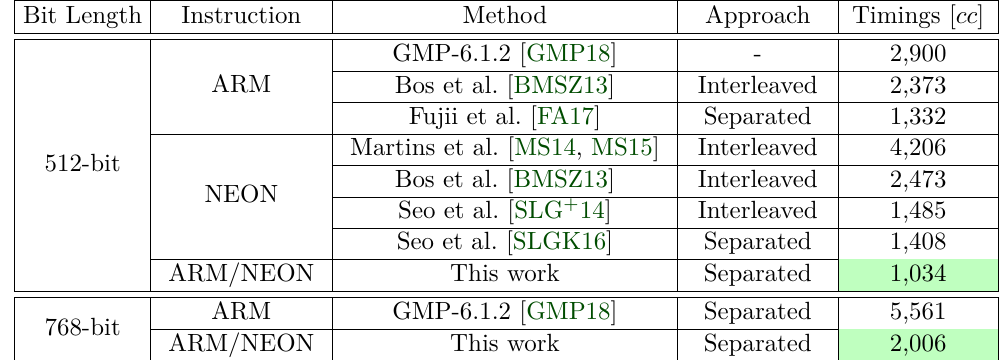
Table 4: Comparison of different 512-bit and 768-bit Montgomery multiplication imple- mentations. Results (in clock cycles) were obtained on an ARM